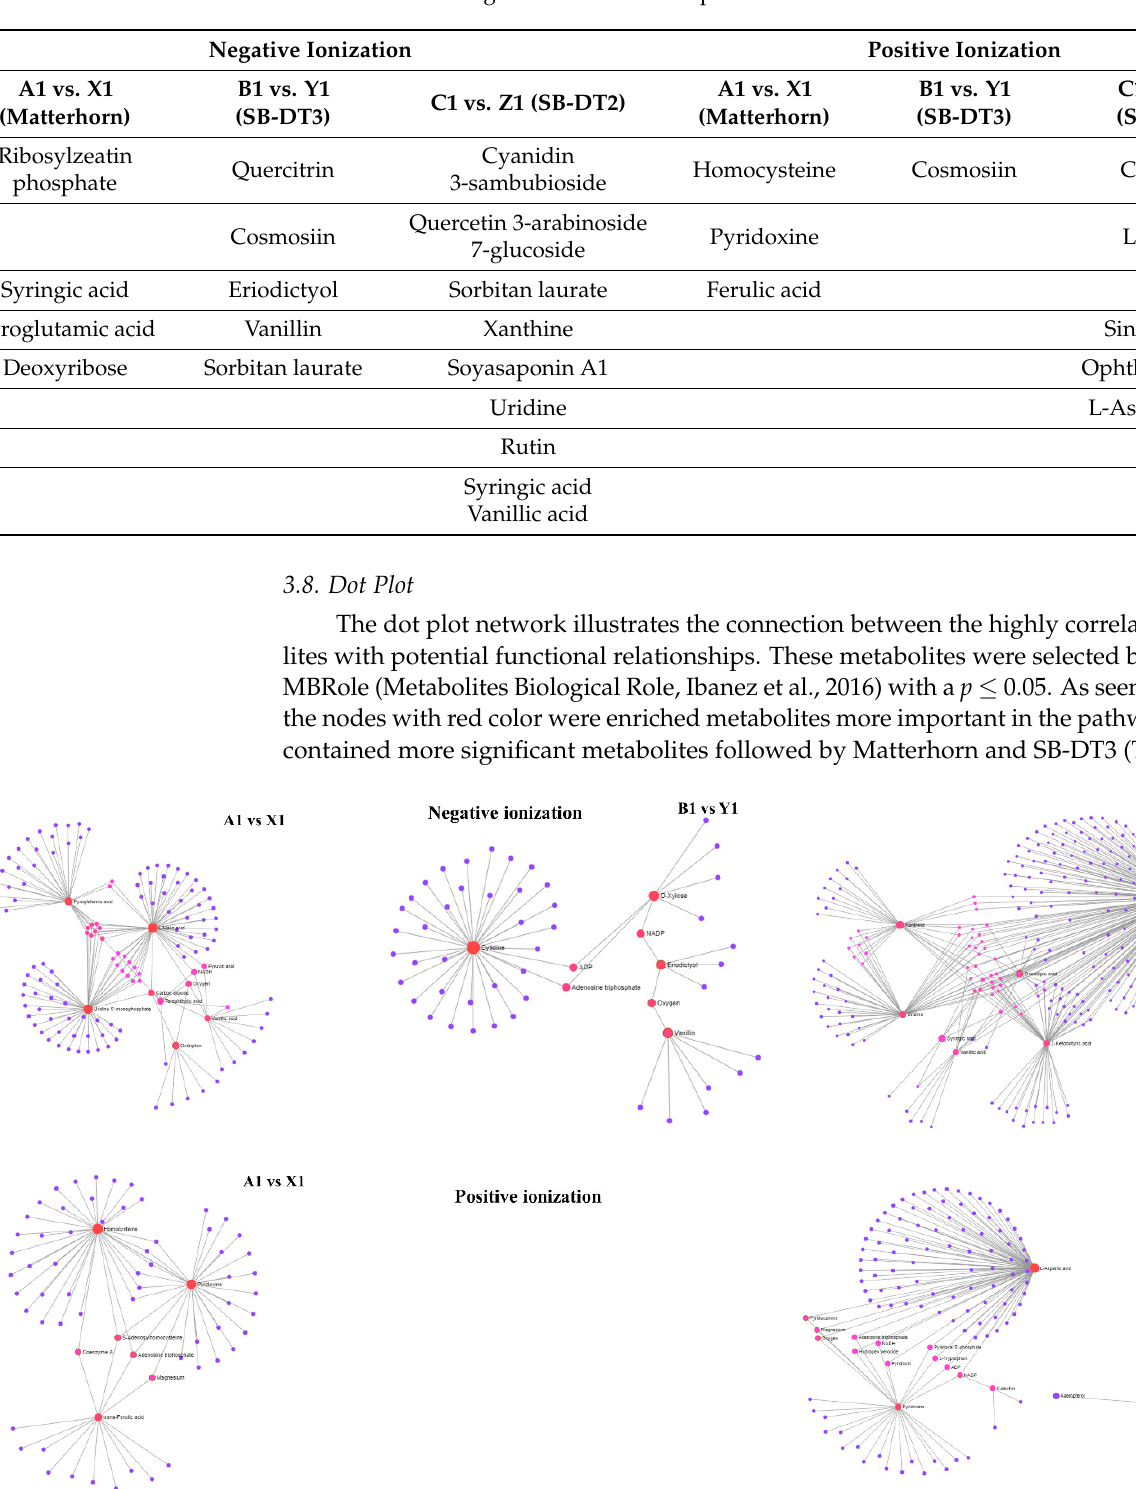
Table 1. Identification of potential metabolites in both ionization modes. These were selected with VIP > 1.5, log2 (fold change) > 1, and p < 0.05. A total of 26 metabolites was identified. Genotype SB-DT2 showed a higher accumulation of potential metabolites.